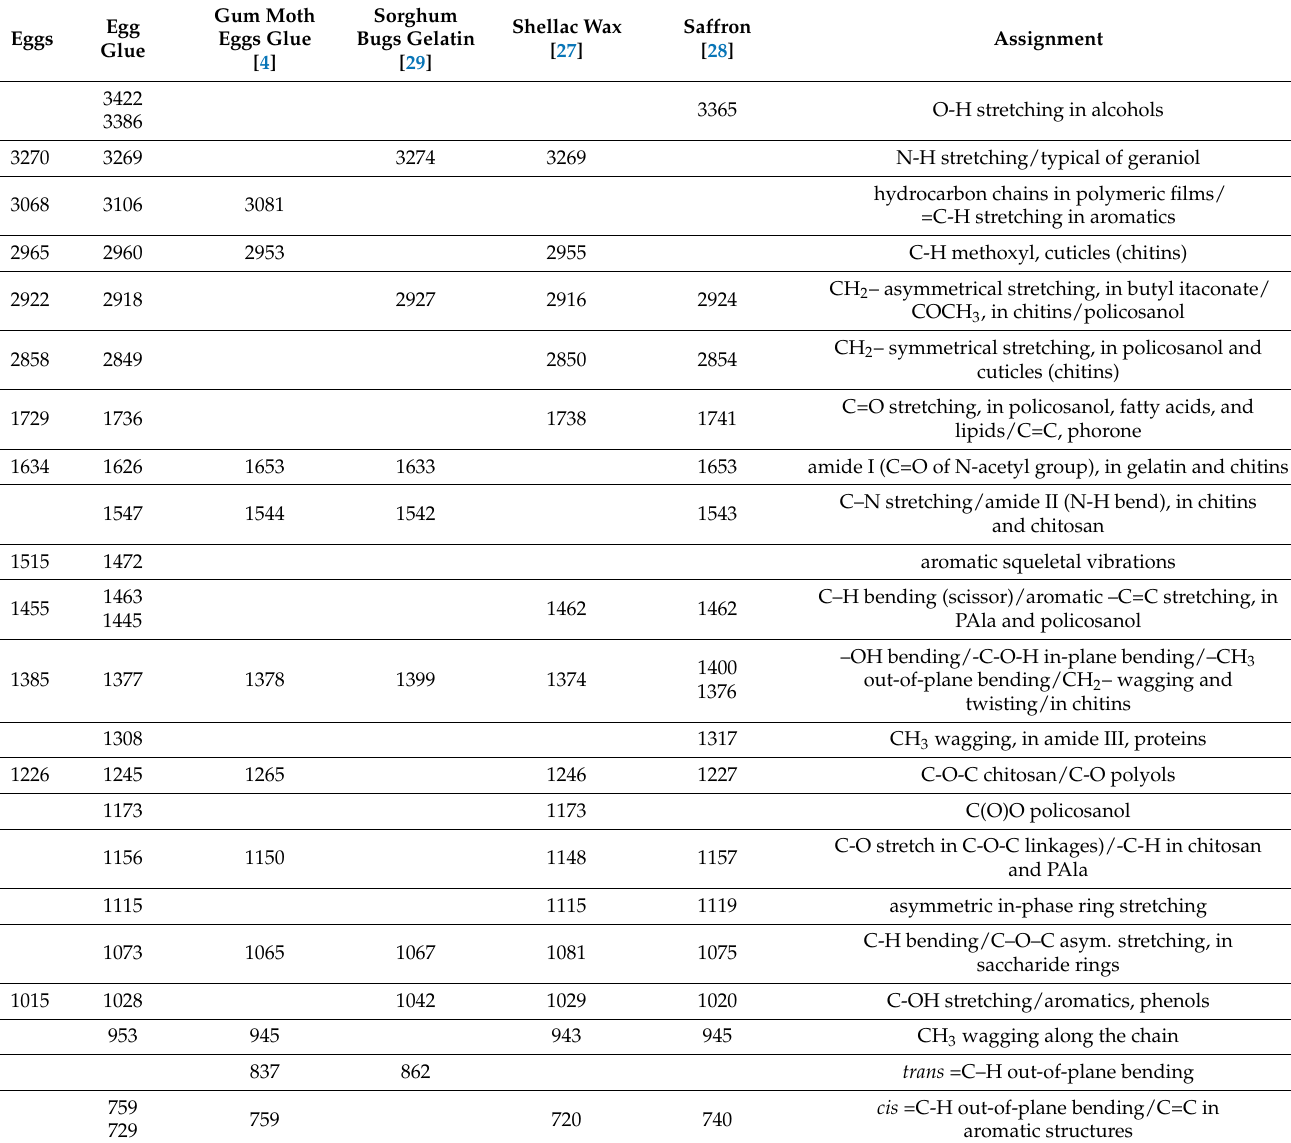
Table 2. Main infrared absorption bands of western conifer seed bug eggs and egg glue and possible assignments, together with bands reported in the literature (for comparison